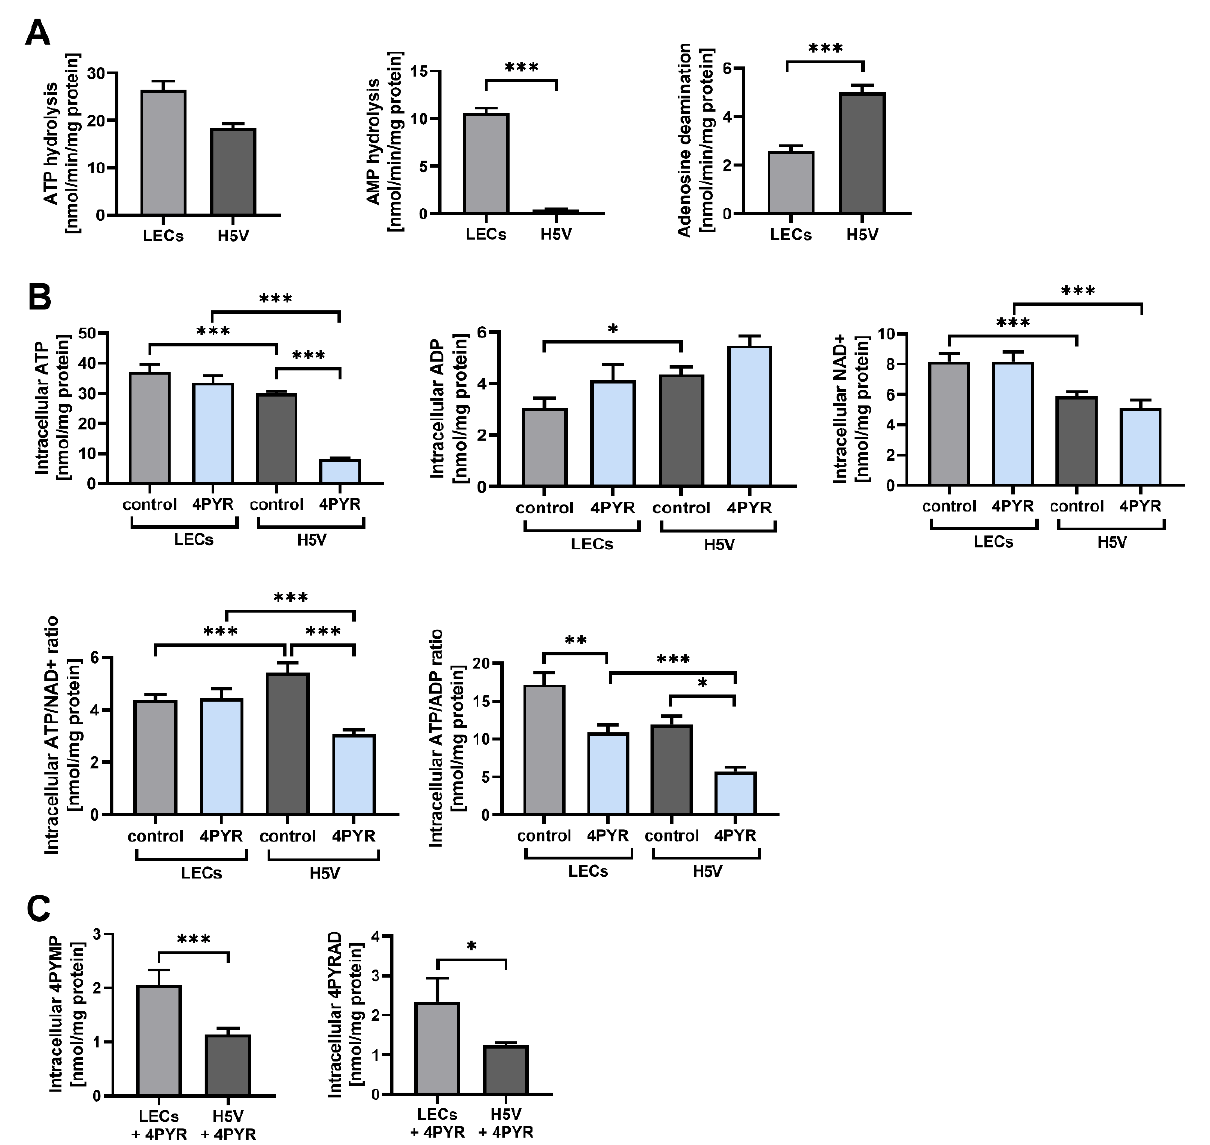
Figure 5. Heterogeneity in the energy status, oxidoreductive potential, and 4PYR degradation ratio between LECs and H5V cells. ( A ) Comparison between the rate of eATP hydrolysis, eAMP hydrolysis, and eAdo deamination in LECs and H5V cell cultures. Enzymatic activities were measured via reversed-phase HPLC after 24 h of culture. Graphs represent the mean ± SEM from six independent experiments. *** p < 0.001. ( B , C ) Effect of 4PYR (100 µ M) on the intracellular concentration of nucleotides and their catabolites ( B ), and 4PYR metabolites ( C ) in LECs and H5V cells, relative to vehicle-treated control. Cell extracts were analyzed via reversed-phase HPLC after 72 h of cell culture. Protein concentration was measured with the Bradford method in protein precipitates. Graphs represent normalized averages ± SEM from six independent experiments. * p < 0.05, ** p < 0.01, *** p <